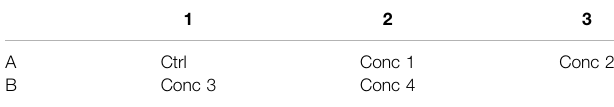
TABLE 10 | Treatment example. TABLE 11 | Plate con fi guration for